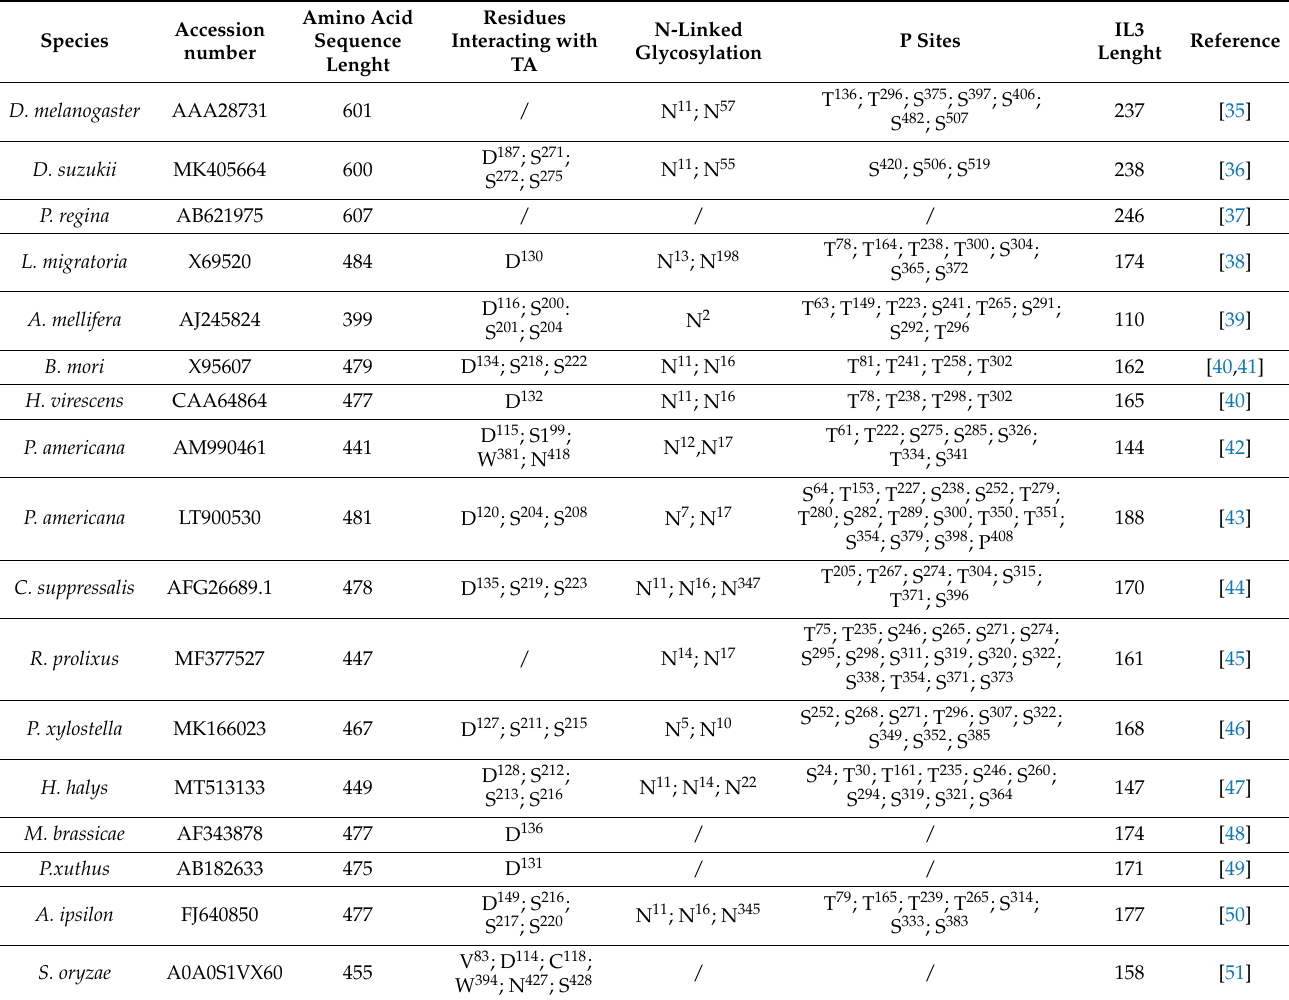
Table 1. Molecular features of TAR1s cloned from